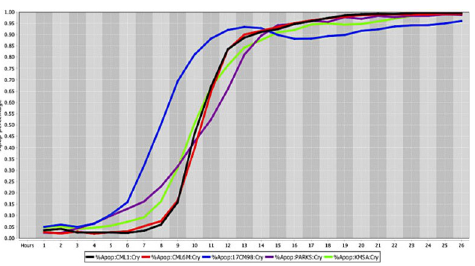
Fig 3. Cell death response curve for canine melanoma. Cell death response expressed in percentage of apoptosis in canine melanoma cell lines exposed to CT at 20 μ M concentration (CML1- black line, CML6M- red line,17CM98- blue line, PARKS- purple line, KMSA- neon green